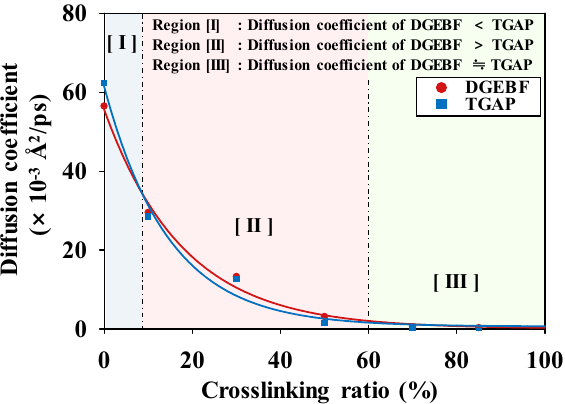
Figure 7. Diffusion coefficients of DGEBF and TGAP as functions of the crosslinking ratio at 180 °C. The red and blue dots represent the diffusion coefficients of DGEBF and TGAP, respectively. The red and blue lines represent the fitting data for DGEBF and TGAP,